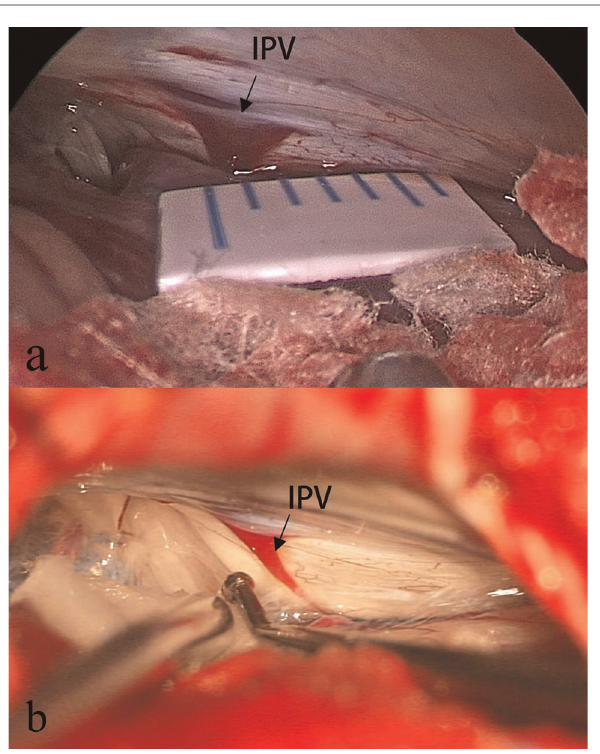
FIGURE 1 | IPV location and intraoperative measurement. The IPV is always near the lower cranial nerves, and after passing through the arachnoid membrane, it drains into the jugular bulb. To measure IPV diameter, we use a ruler ( A ) placed within the operative area during the surgical procedure, and sometimes we use a vascular separator as reference ( B